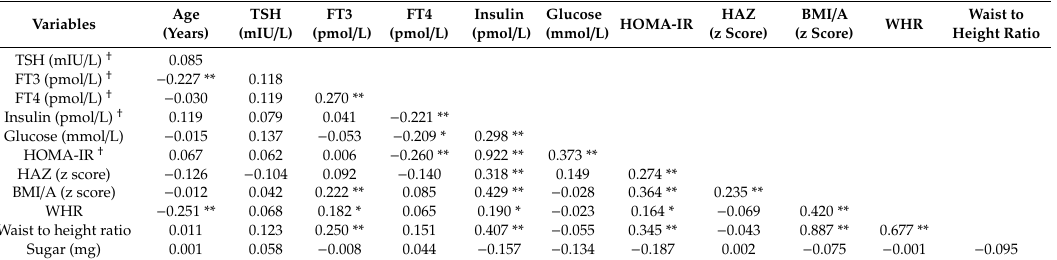
Table 6. Correlations between hormones and anthropometric data at follow-up a .